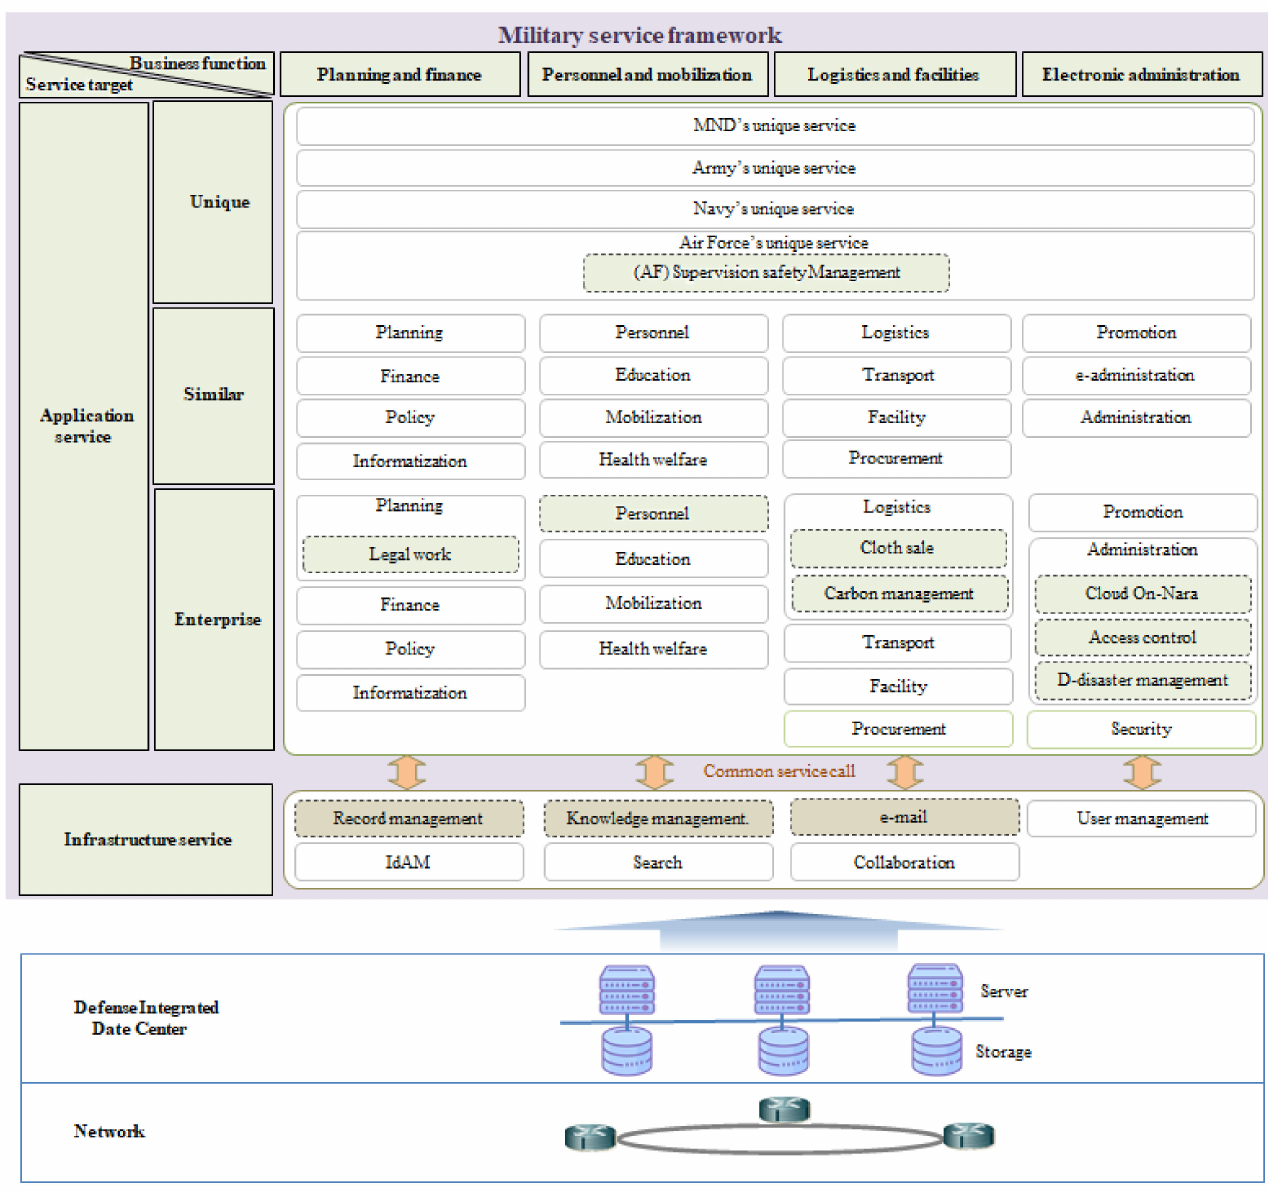
Figure 7. Restructured future